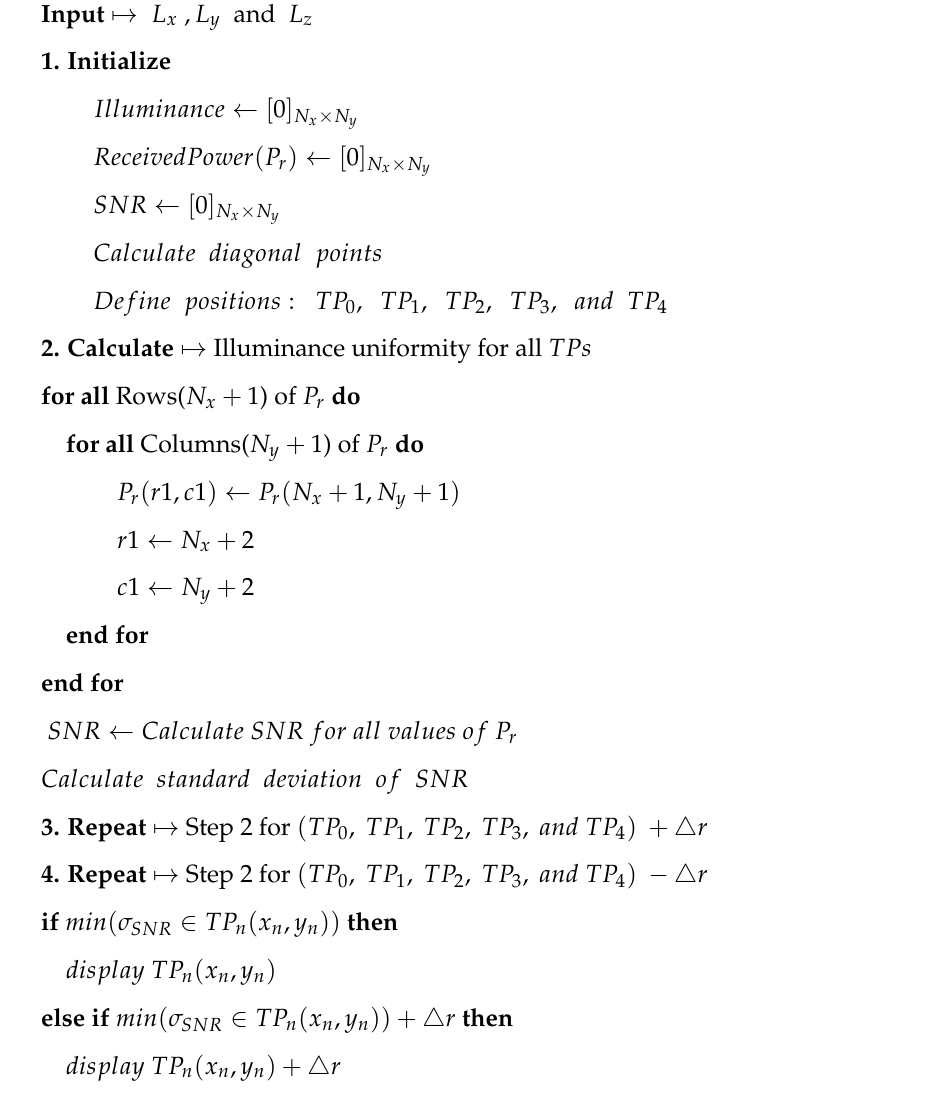
Algorithm 1 Algorithm to determine coordinates’ for given room size using the proposed